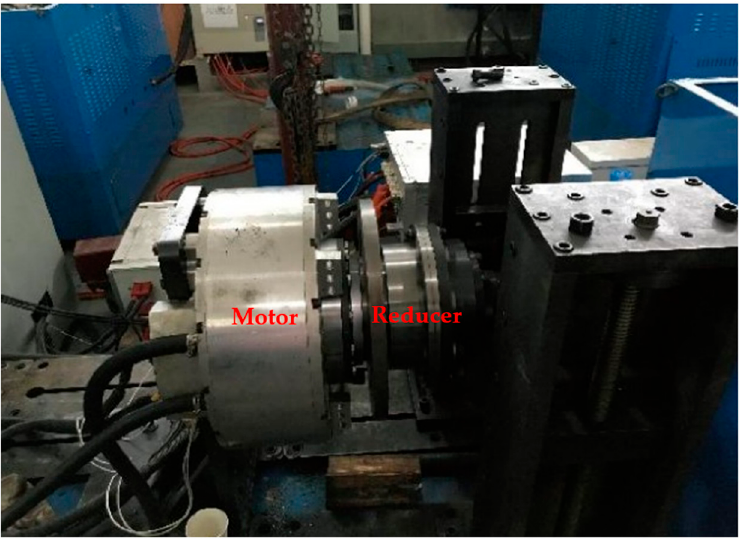
Figure 4. The temperature test experiment.